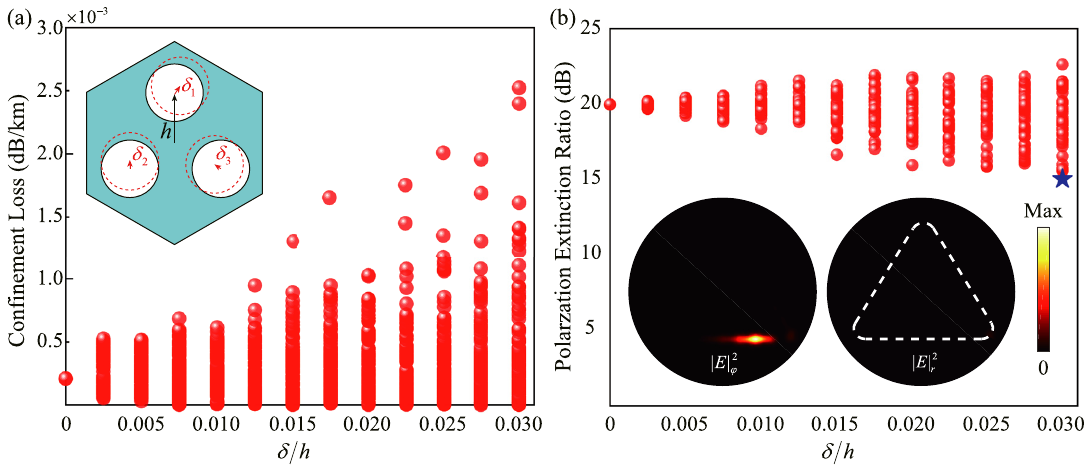
mode of TPCF. All holes in fiber occur the random offsets 𝛿 21 mode, whose polarization 21